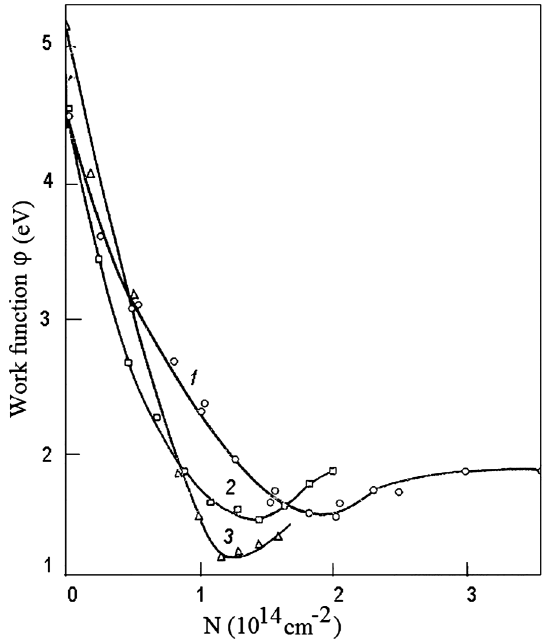
FIG. 11. Dependence of work function on surface cesium concentration for a W surface with different oxygen concentra- tions: (1) clean surface; (2) low oxygen concentration; (3) high oxygen concentration (increase of work function up to 5.3